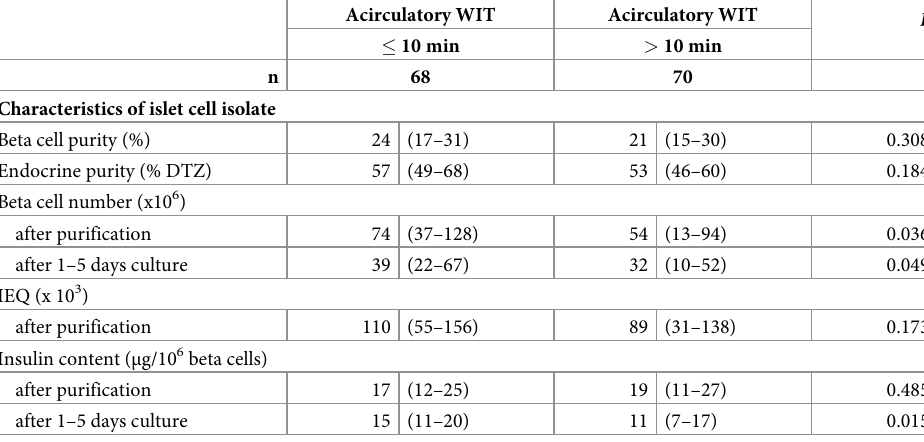
Table 4. Effect of acirculatory warm ischemia time in DCD III.